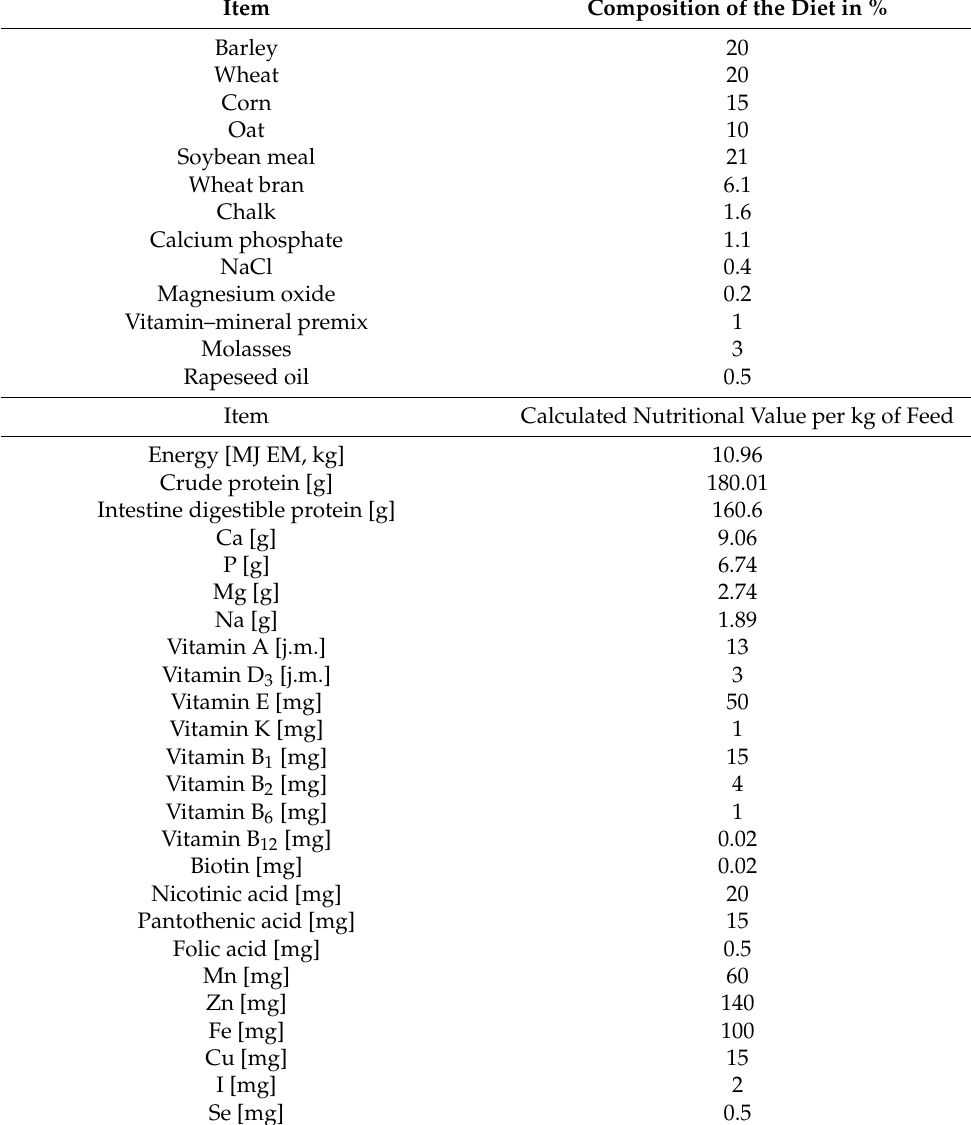
Table 3. Composition and nutritional value of the starter (on DM basis) according to the DGL system